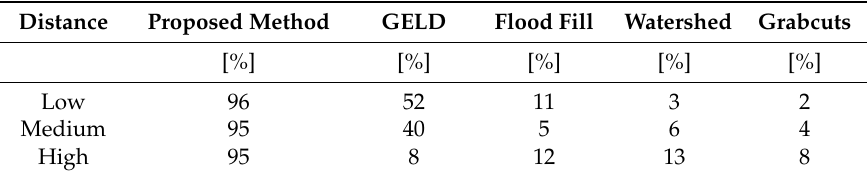
Table 7. The precision of compared